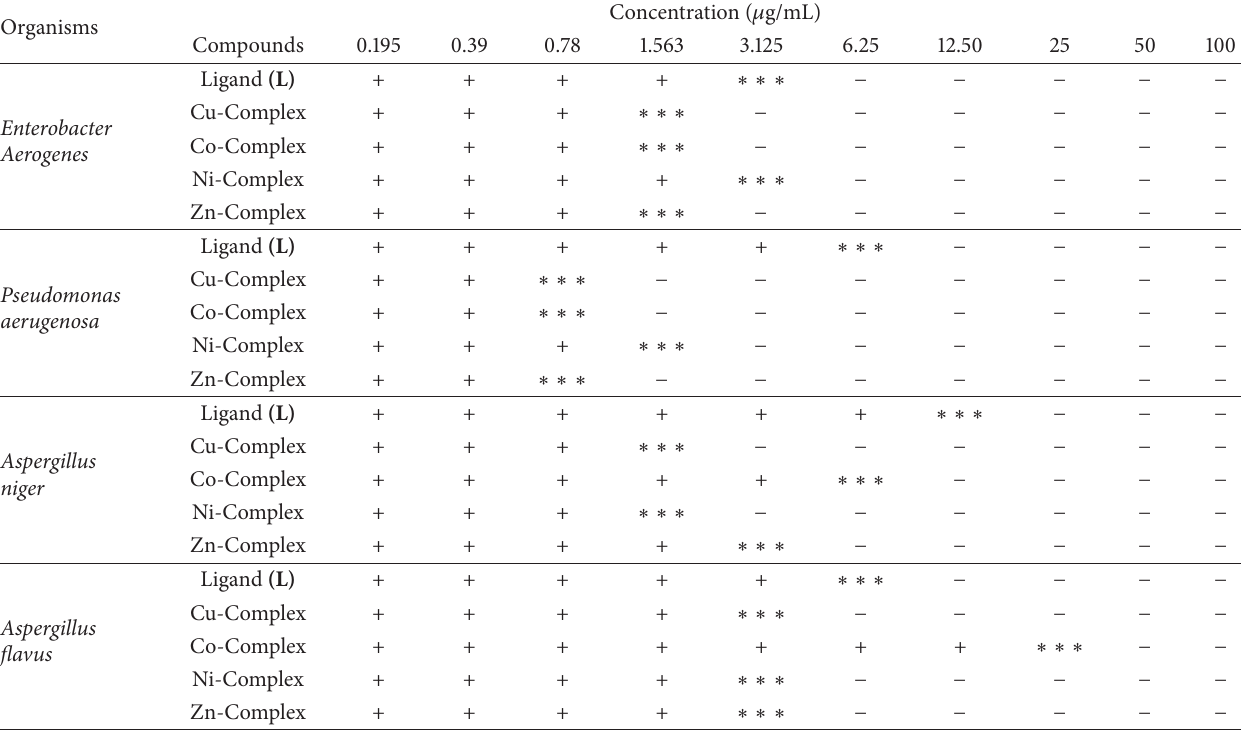
Table 7: Minimum Inhibitory Concentration (MIC in 𝜇 g/mL) of Schiff base ligand (L) and its metal complexes. Organisms